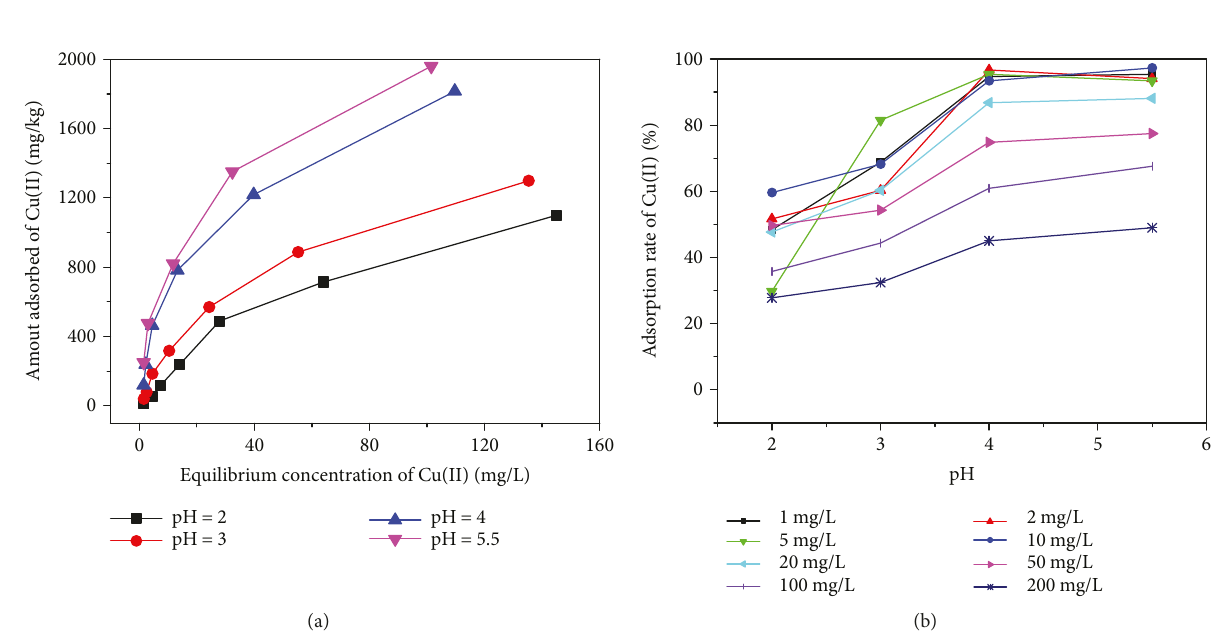
Figure 3: E ff ect of pH on adsorption: (a) adsorbed amount of Cu(II) and (b) adsorption rate of Cu(II).